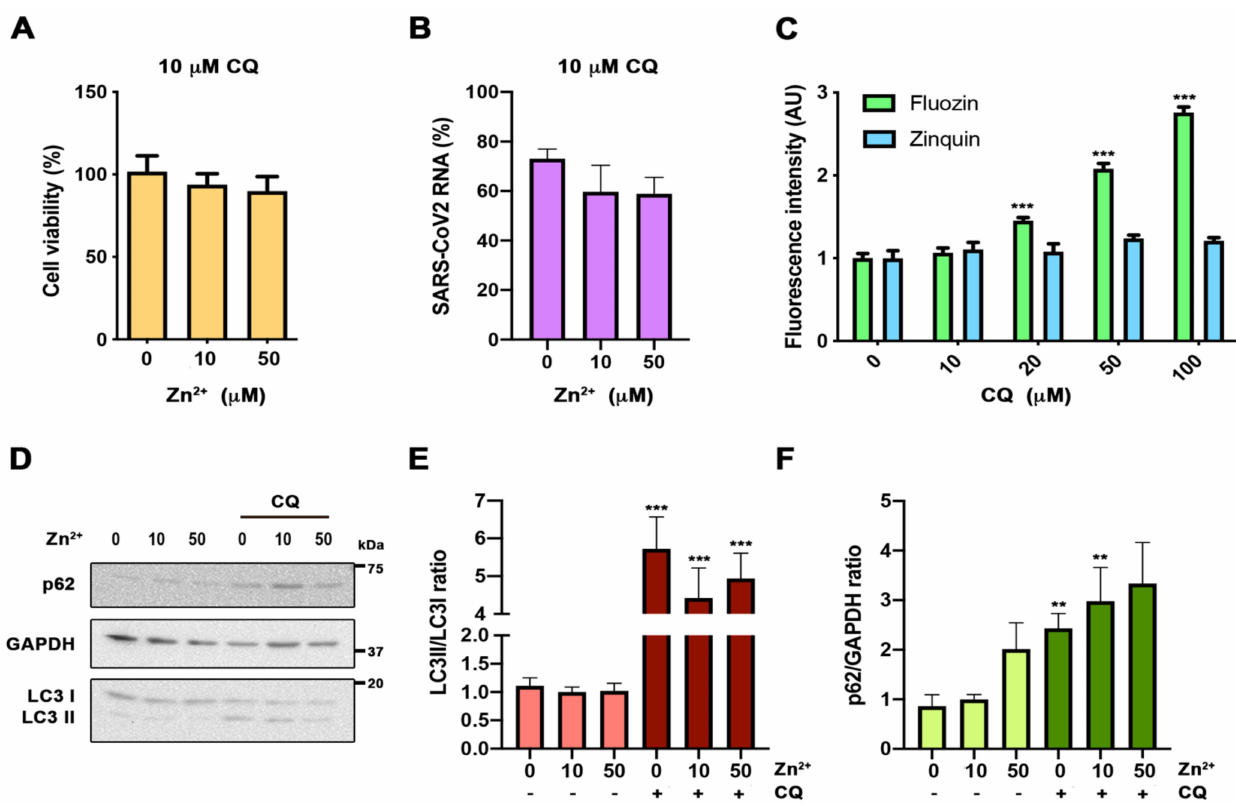
Figure 3. Evaluation of zinc potentiation of chloroquine antiviral action. ( A ) Viability MTT assay in cells incubated with 10 µ M chloroquine (CQ) in 0, 10, and 50 µ M Zn 2+ content for 48 h ( n = 15; Bonferroni-corrected one-way ANOVA compared to 10 µ M Zn 2+ ). ( B ) Quantification in the supernatant of viral RNA copies by qPCR in cells infected with SARS-CoV-2 treated with 10 µ M CQ in 0, 10, and 50 µ M Zn 2+ , and collected at 48 h. Data expressed in percentage compared to control condition (10 µ M Zn 2+ without CQ, Figure ?? D) ( n = 3; Bonferroni-corrected one-way ANOVA compared to 10 µ M CQ in 10 µ M Zn 2+ ). ( C ) Flow cytometry in cells incubated for 30 min with 0, 10, and 50 µ M extracellular Zn 2+ content using FluoZin-3AM and Zinquin probes. Intensity expressed in arbitrary units (AU) ( n ≥ 4; *** p < 0.001; Bonferroni-corrected one-way ANOVA compared to 0 µ M Zn 2+ from each probe). ( D – F ) Western blot analysis from cells incubated for 24 h in 0, 10, and 50 µ M Zn 2+ with or without 10 µ M CQ. Antibodies against microtubule-associated proteins 1A/1B light chain 3B (LC3), p62, and glyceraldehyde 3-phosphate dehydrogenase (GAPDH). ( D ) Representative blot. ( E , F ) Quantification of the bands for LC3 (( E ) n ≥ 10) and p62 (( F ) n ≥ 7) (Bonferroni-corrected one-way ANOVA compared to 10 µ M Zn 2+ or 10 µ M CQ in 10 µ M Zn 2+ ; ** p < 0.01, *** p < 0.001 unpaired t -test comparing conditions with and without